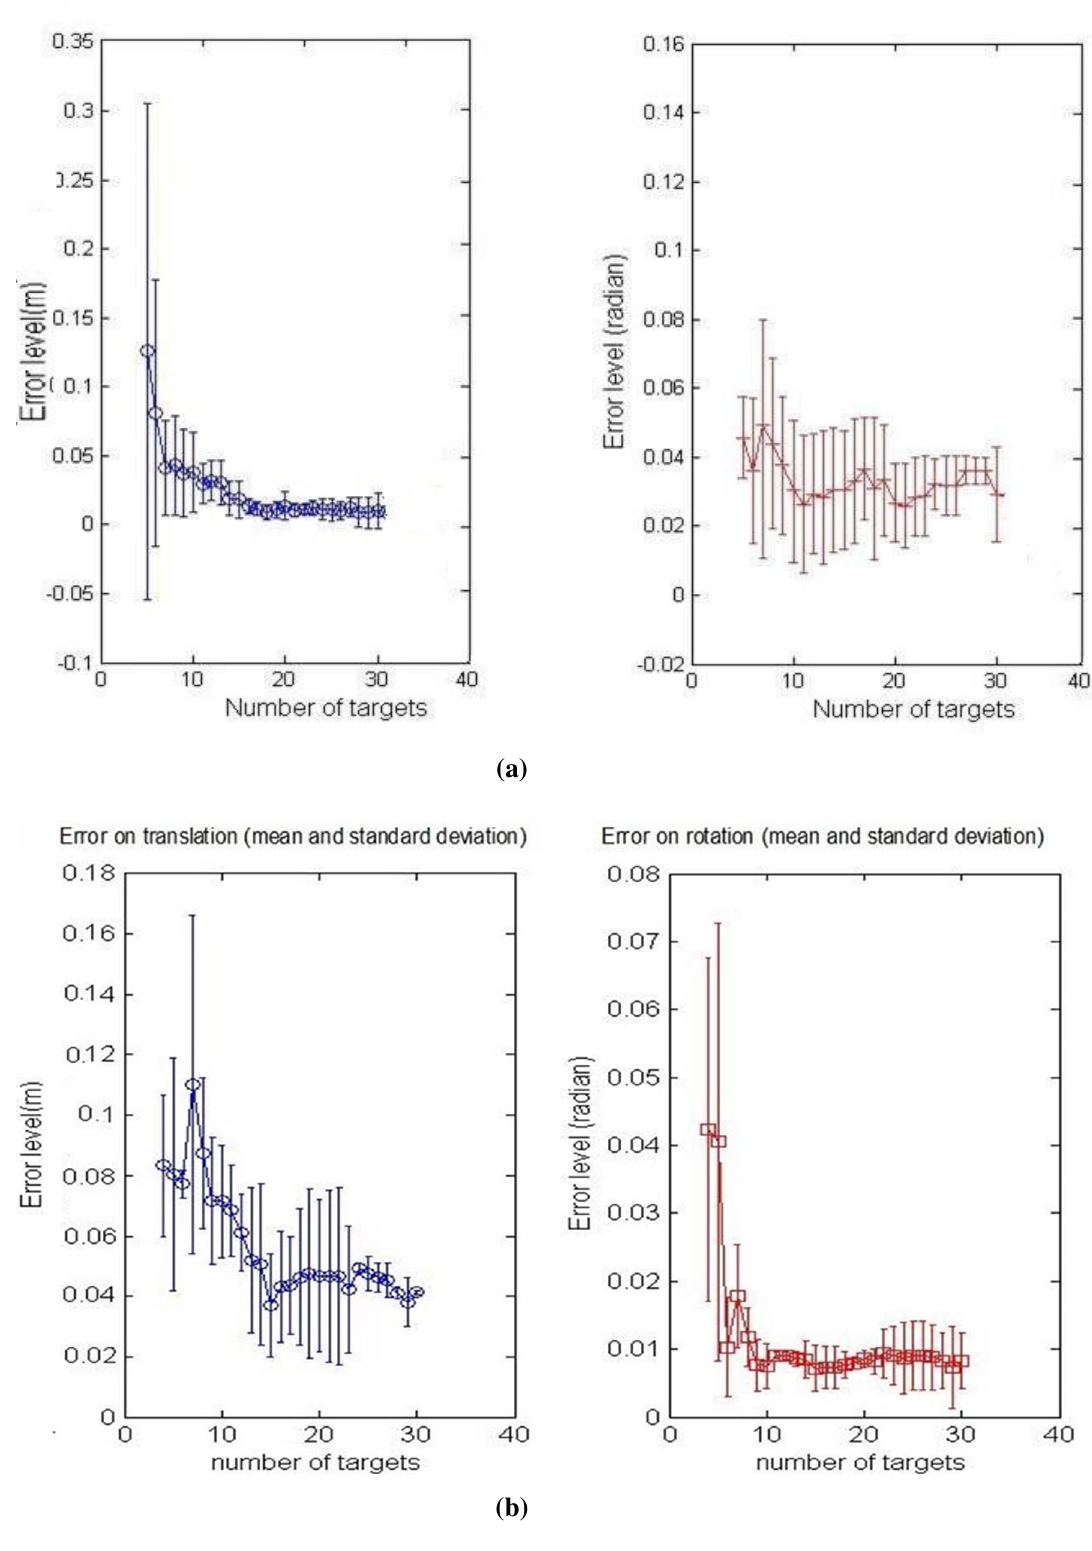
Figure 7. Calibration error with respect to the number of points. Left column : translation error in meters; Right column : rotation error in radians. The graphs show the mean and the standard deviation of RMSE upon six iterations. The number of matches is increased by a step of one from three to 30, and the noise level is: ± 2 p, ± 2 ◦ for α , ± 2 cm for r . ( a ) First calibration method; ( b ) Second calibration